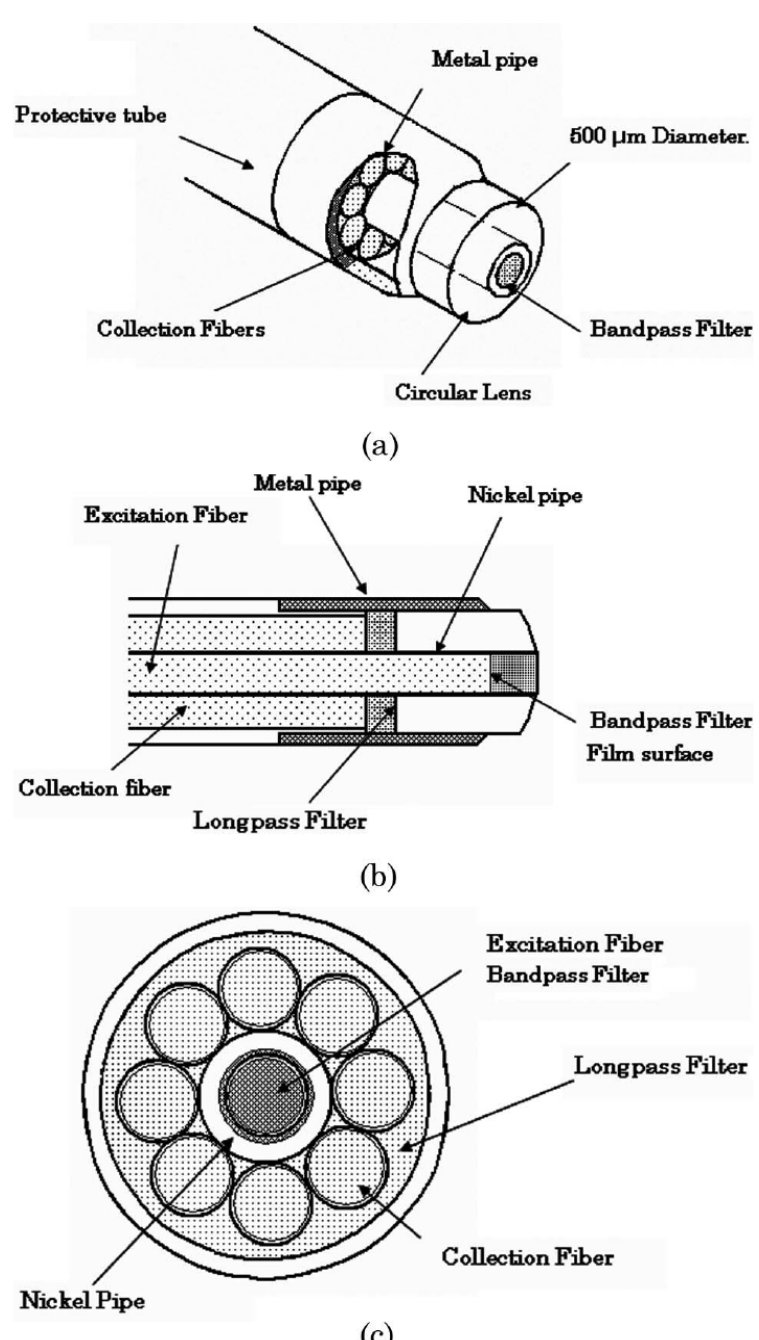
Figure 8. (a) Structure of distal end of a micro Raman probe (MRP). (b) Longitudinal cross section of distal end of a MRP. (c) Transverse cross section at fiber-filter interface. © 2009 Optical Society of